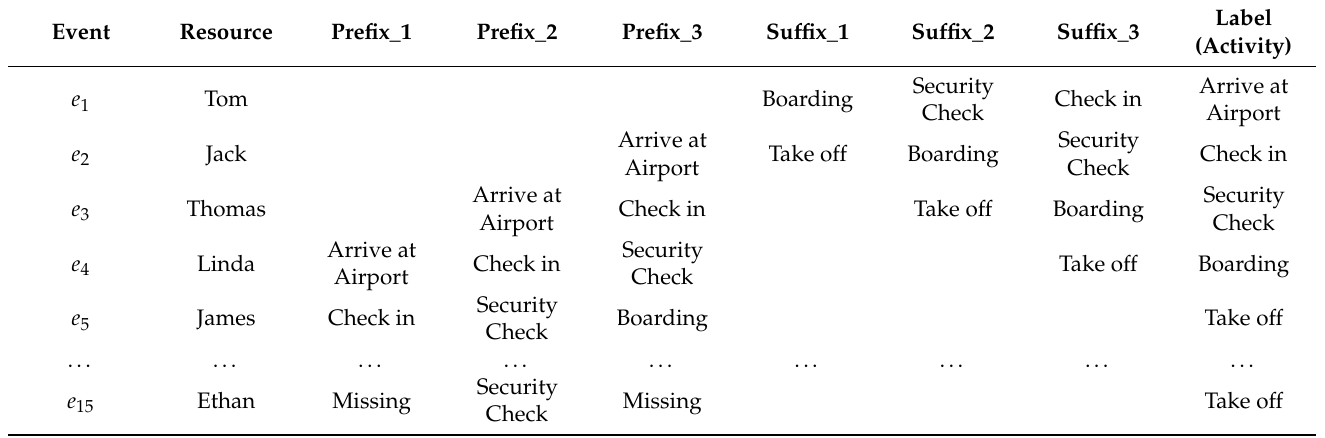
Table 3. The example dataset constructed from E complete .